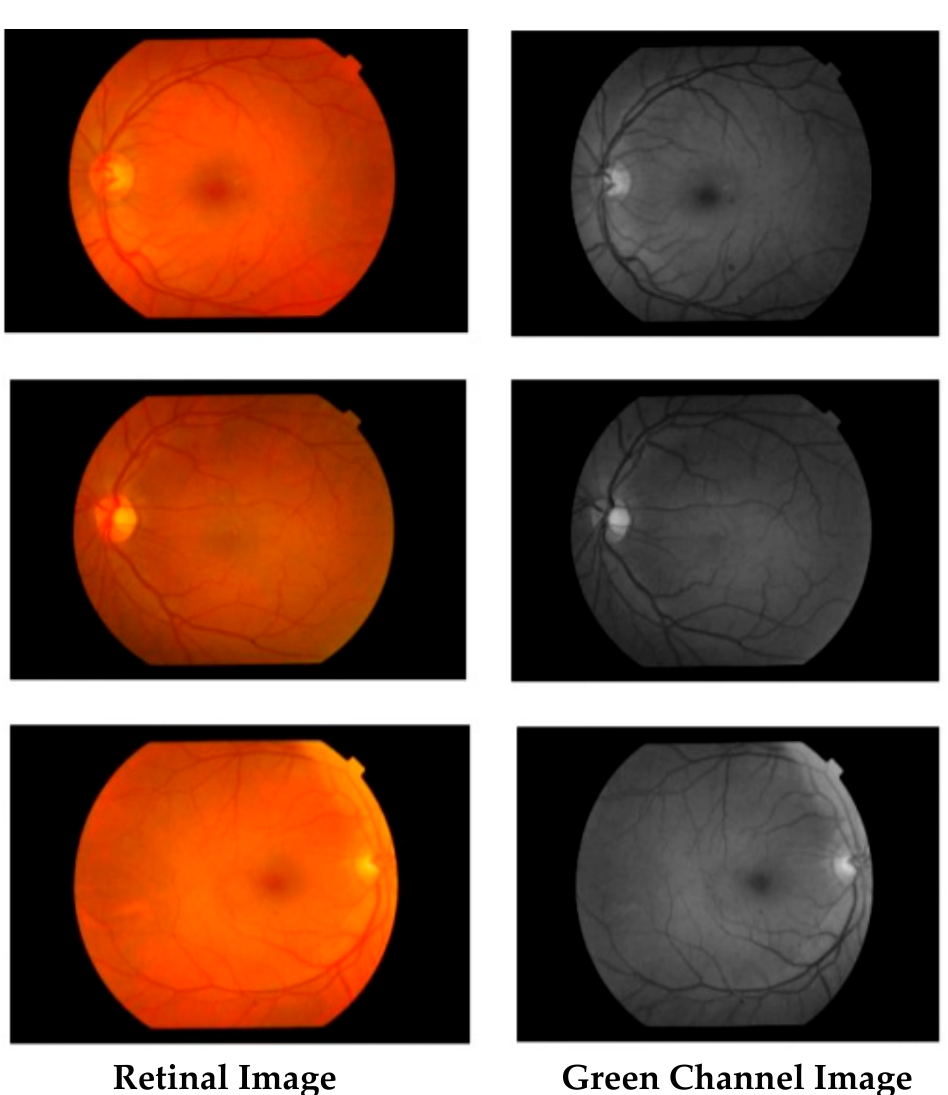
Figure 3. Retinal fundus images and their green channel images.